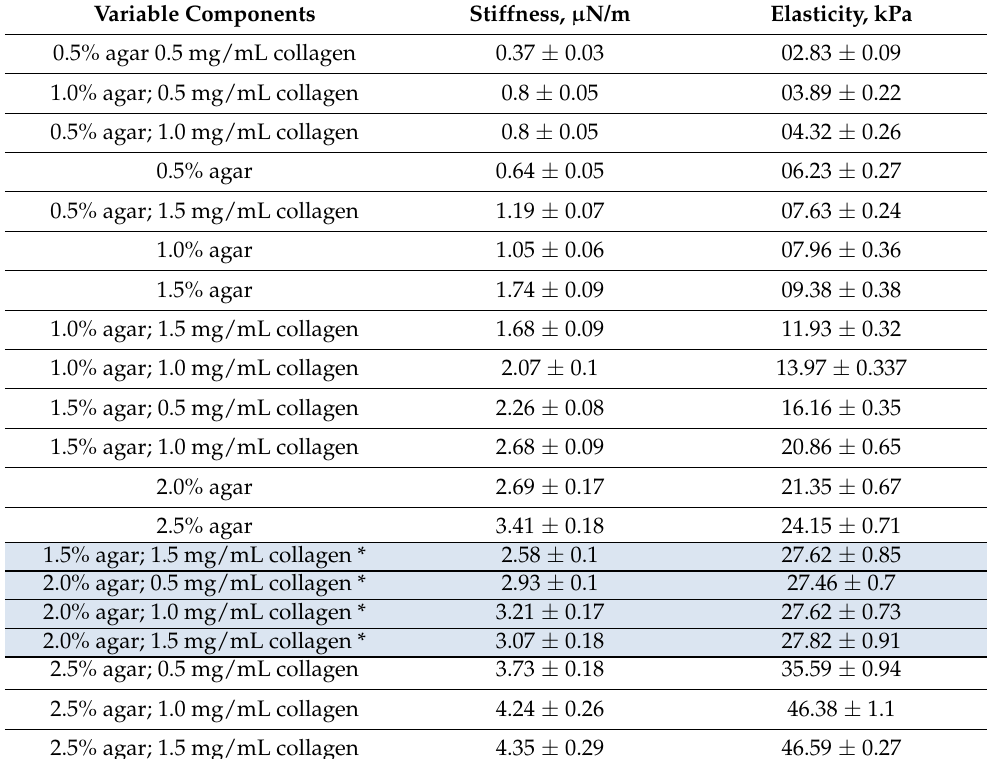
Table 1. Rheological/mechanical properties of different embedding matrix